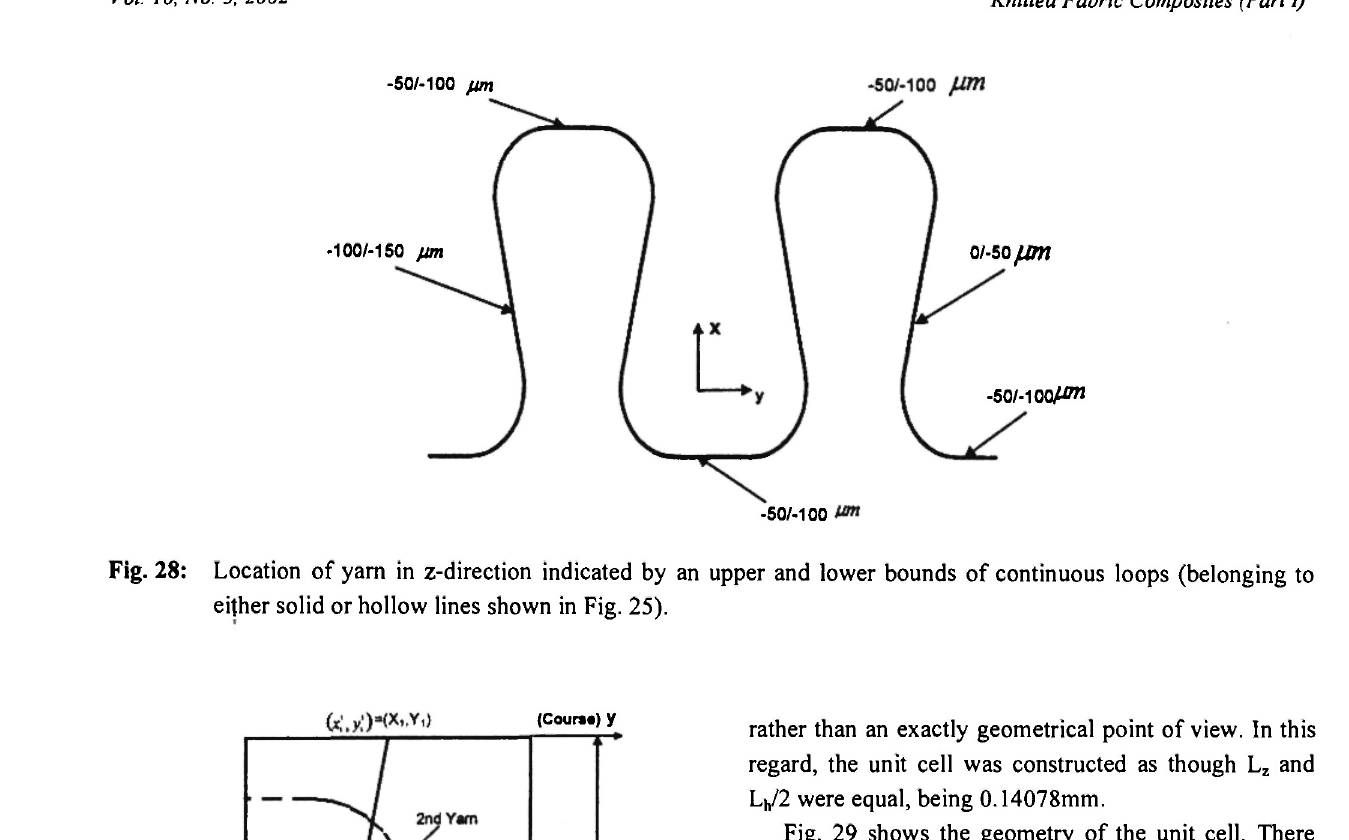
Fig. 29: Unit cell of a textile elastomeric composite and its